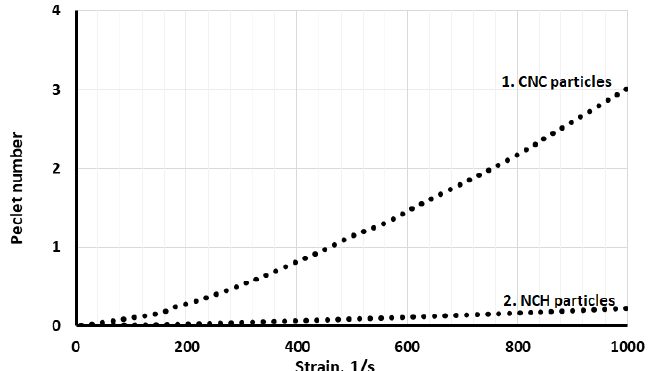
Figure 4. Peclet number of CNC and Nanochitosan (NCH) particles. Table 1. Digital Light Scattering (DLS)